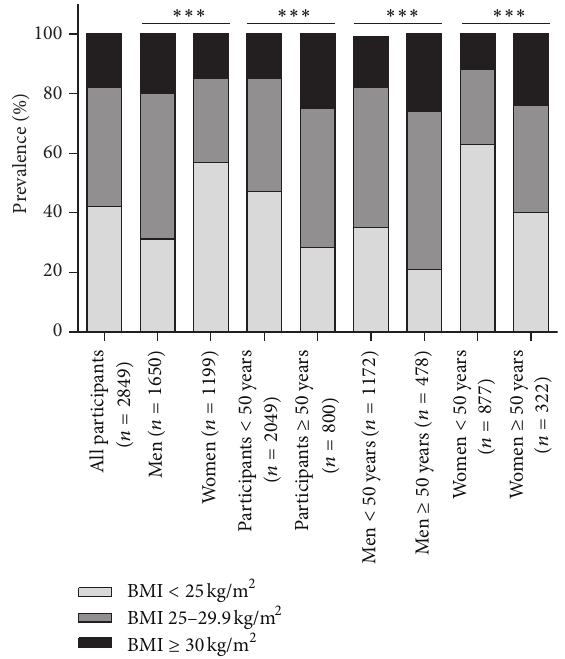
Figure 1: Prevalence of overweight and obesity. Normal weight was defined as BMI < 25kg/m 2 , overweight as BMI 25–29.9 kg/m 2 and obesity as BMI ≥ 30 kg/m 2 . Differences were determined by Chi- square test ( ∗∗∗ 𝑃 < 0.001